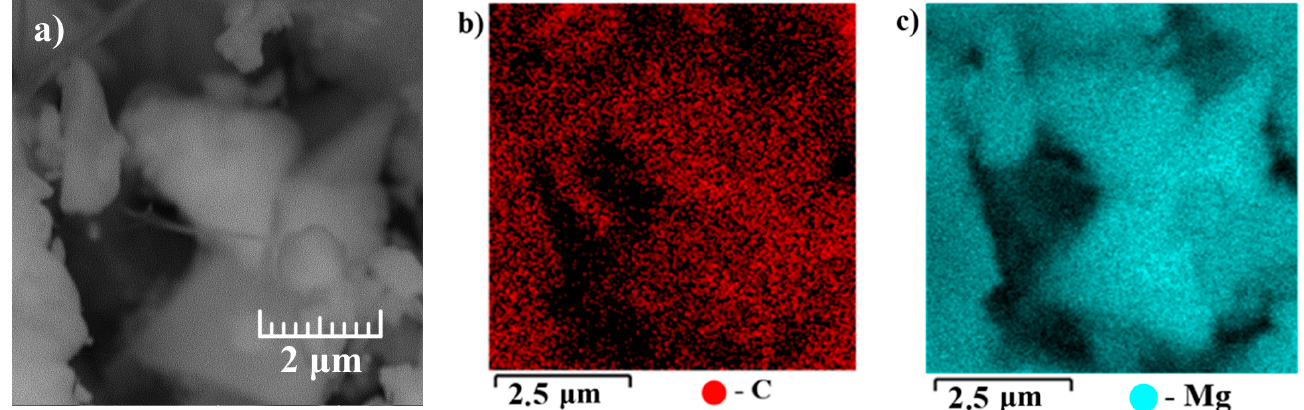
Figure 5. SEM image ( a ) and map of distribution of carbon ( b ) and magnesium ( c ) elements of the MgH 2 –5 wt.% SWCNT composite obtained after 180 min of ball milling at a speed of 300 rpm.